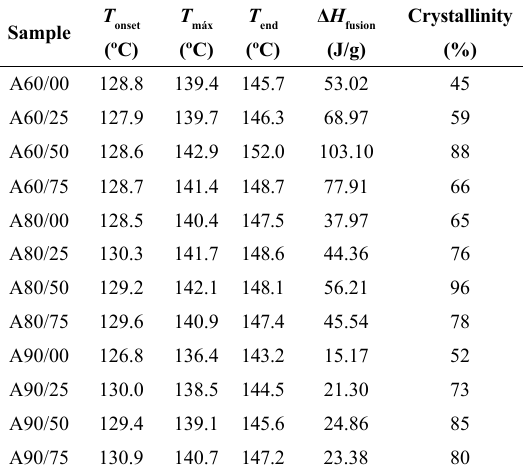
Table 3. DSC average